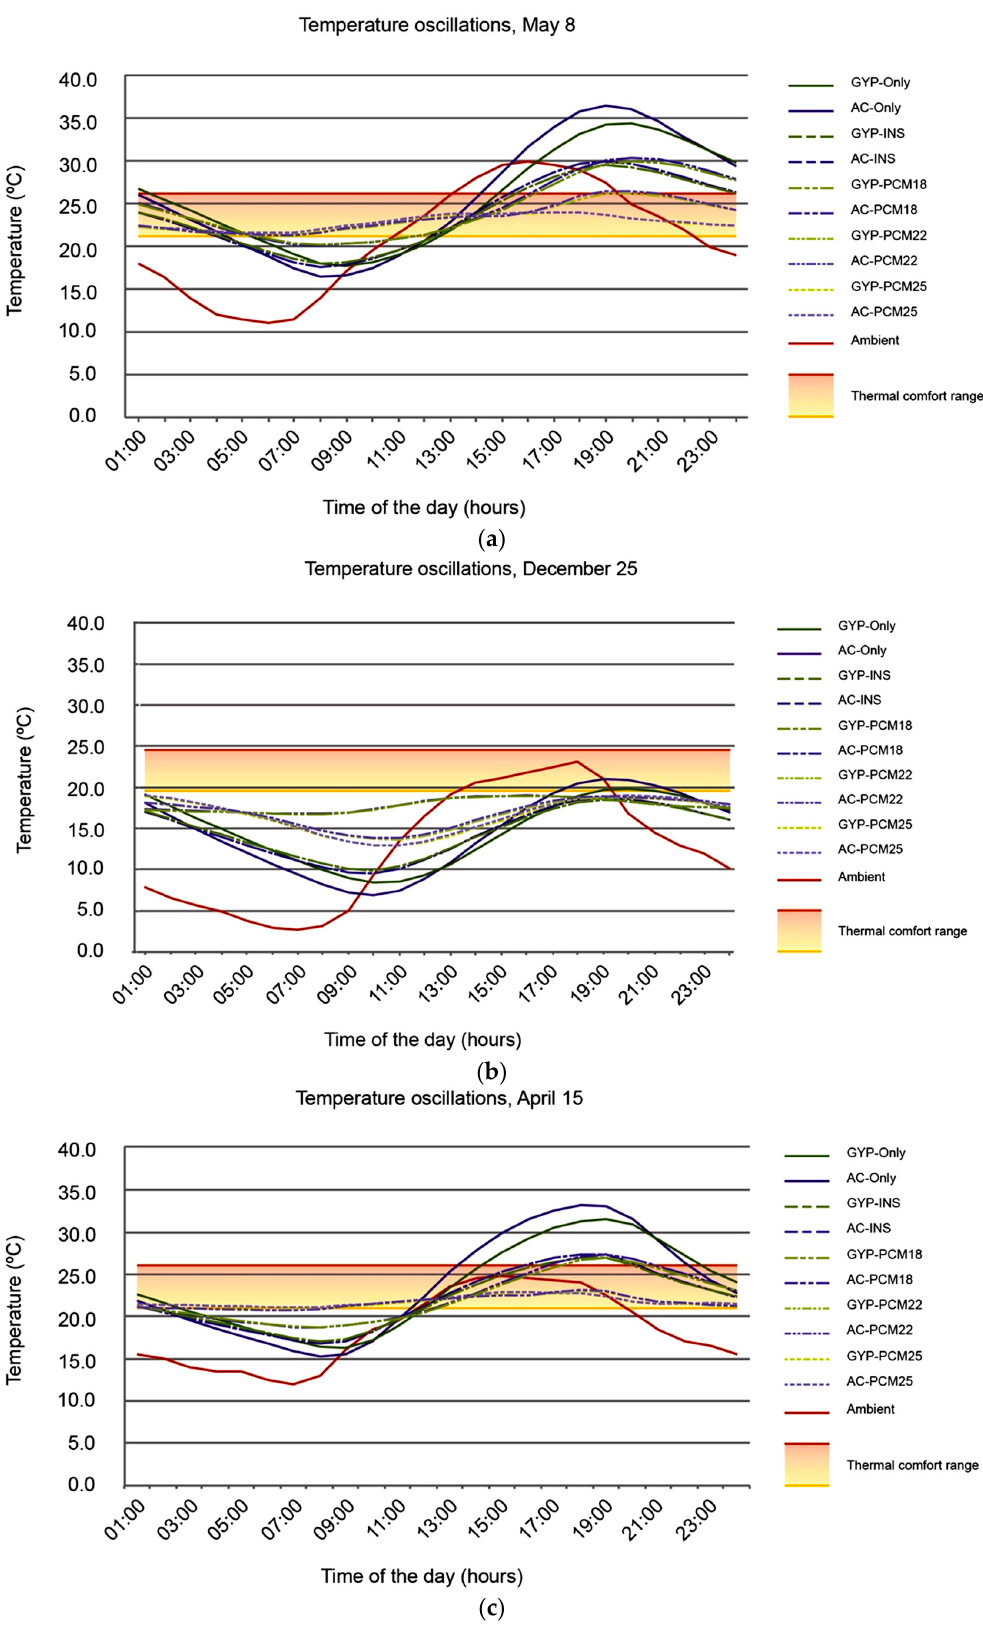
Figure 6. All case scenarios indoor temperature oscillations temperature corresponding to ( a ) 8 May, ( b ) 25 December, and ( c ) 15 April.